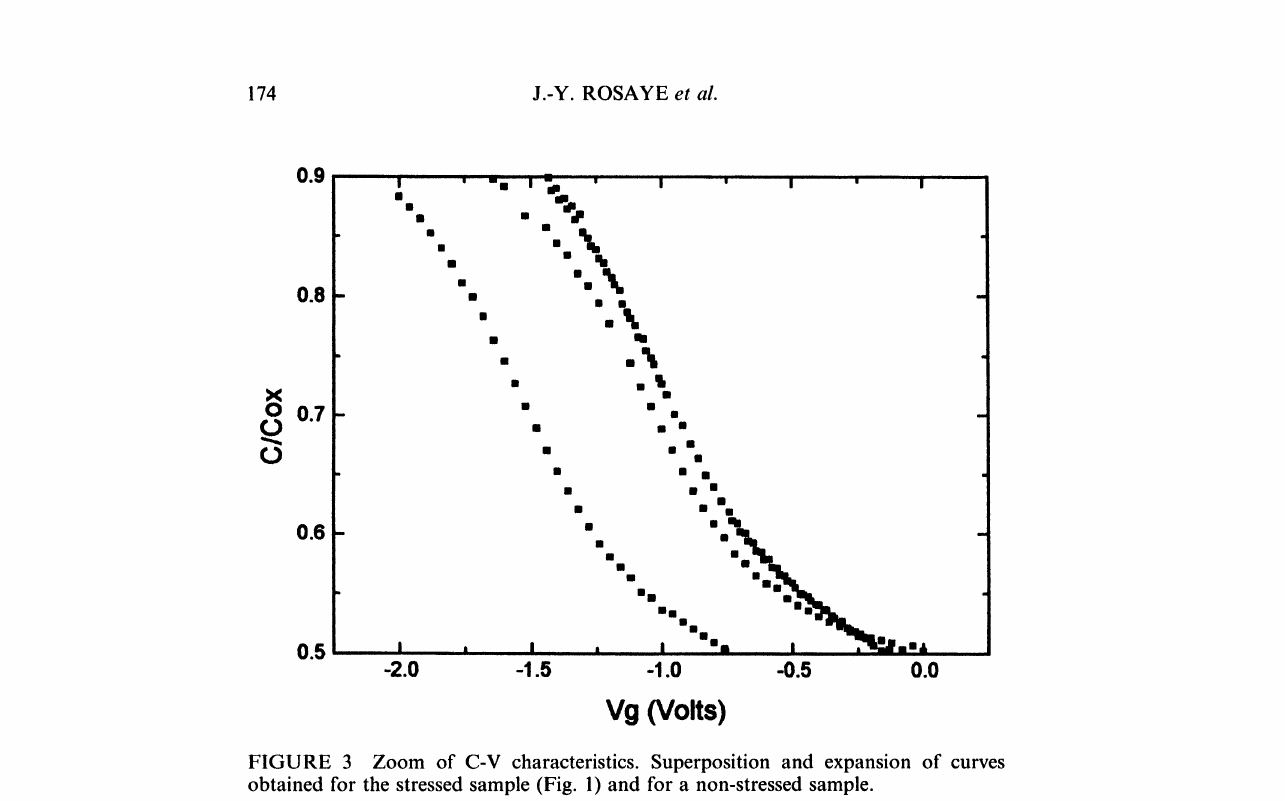
FIGURE 3 Zoom of C-V characteristics. Superposition and expansion of curves obtained for the stressed sample (Fig. 1) and for a non-stressed